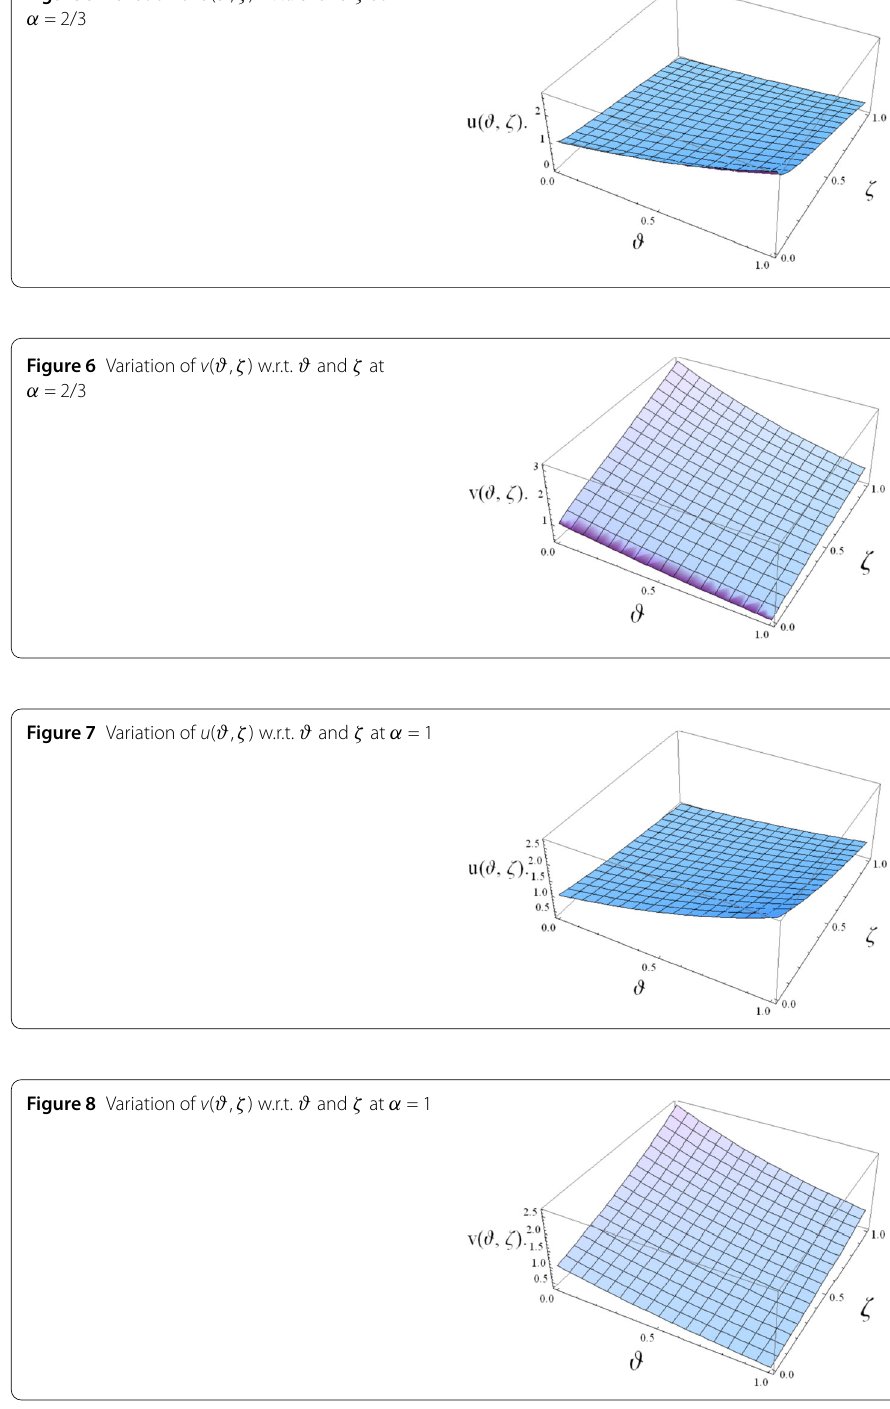
Figure 5 Variation of u ( ϑ , ζ ) w.r.t. ϑ and ζ at α = 2/3